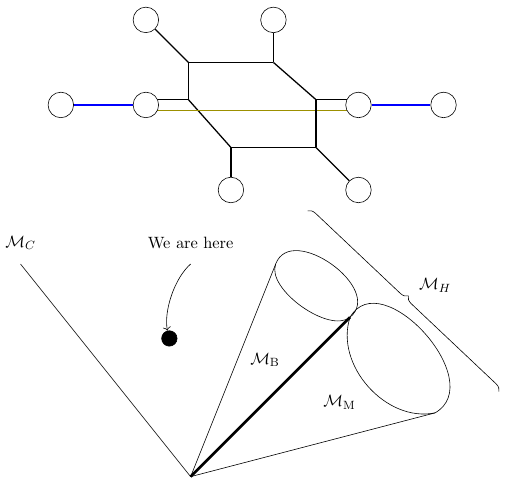
Figure 6 . The mixed branch is indicated in the brane web. Coloured branes are assumed to be on different ( x 7 , x 8 , x 9 ) positions in